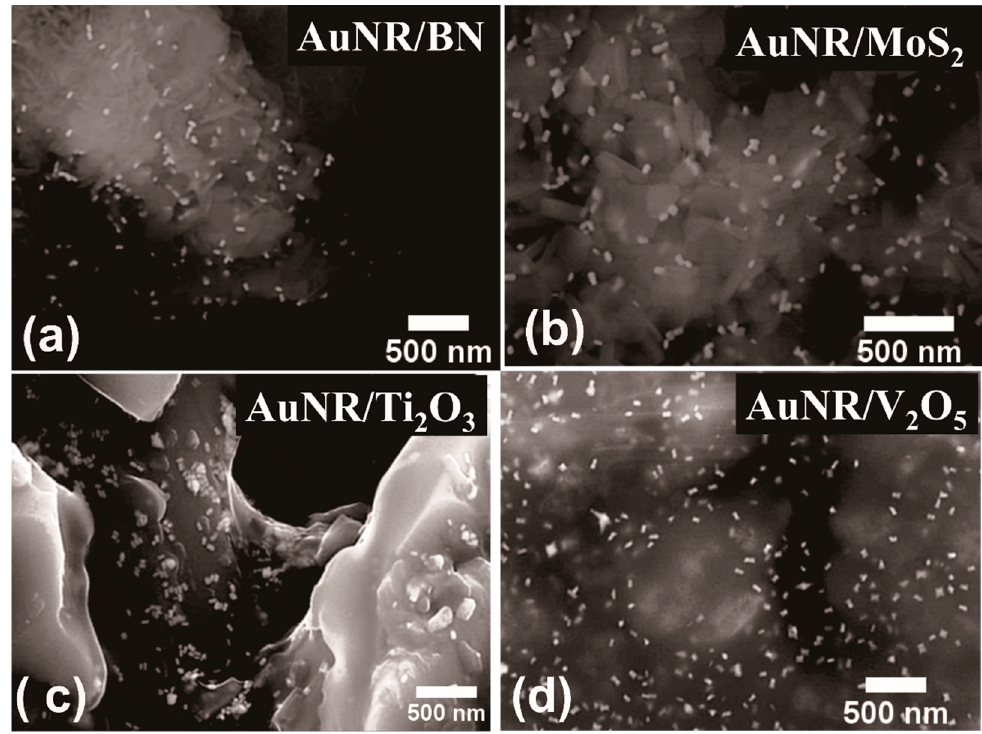
Figure 2 . Scanning Electron Micrographs (SEM) from the as-synthesized short anisotropic gold nanorods (AuNRs) on different supports: ( a ) BN, ( b ) MoS 2 , ( c ) Ti 2 O 3 , and ( d ) V 2 O 5 supports, respectively (scale bar: 500 nm). The respective Electron dispersive spectra (EDS) spectra and other supported AuNRs are shown in the Electronic Supporting Information (Figures S1 and S2).